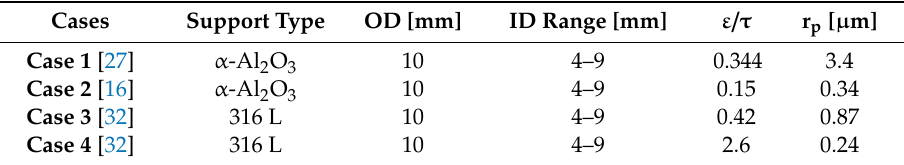
Table 5. Characteristics of the di ff erent cases investigated in this